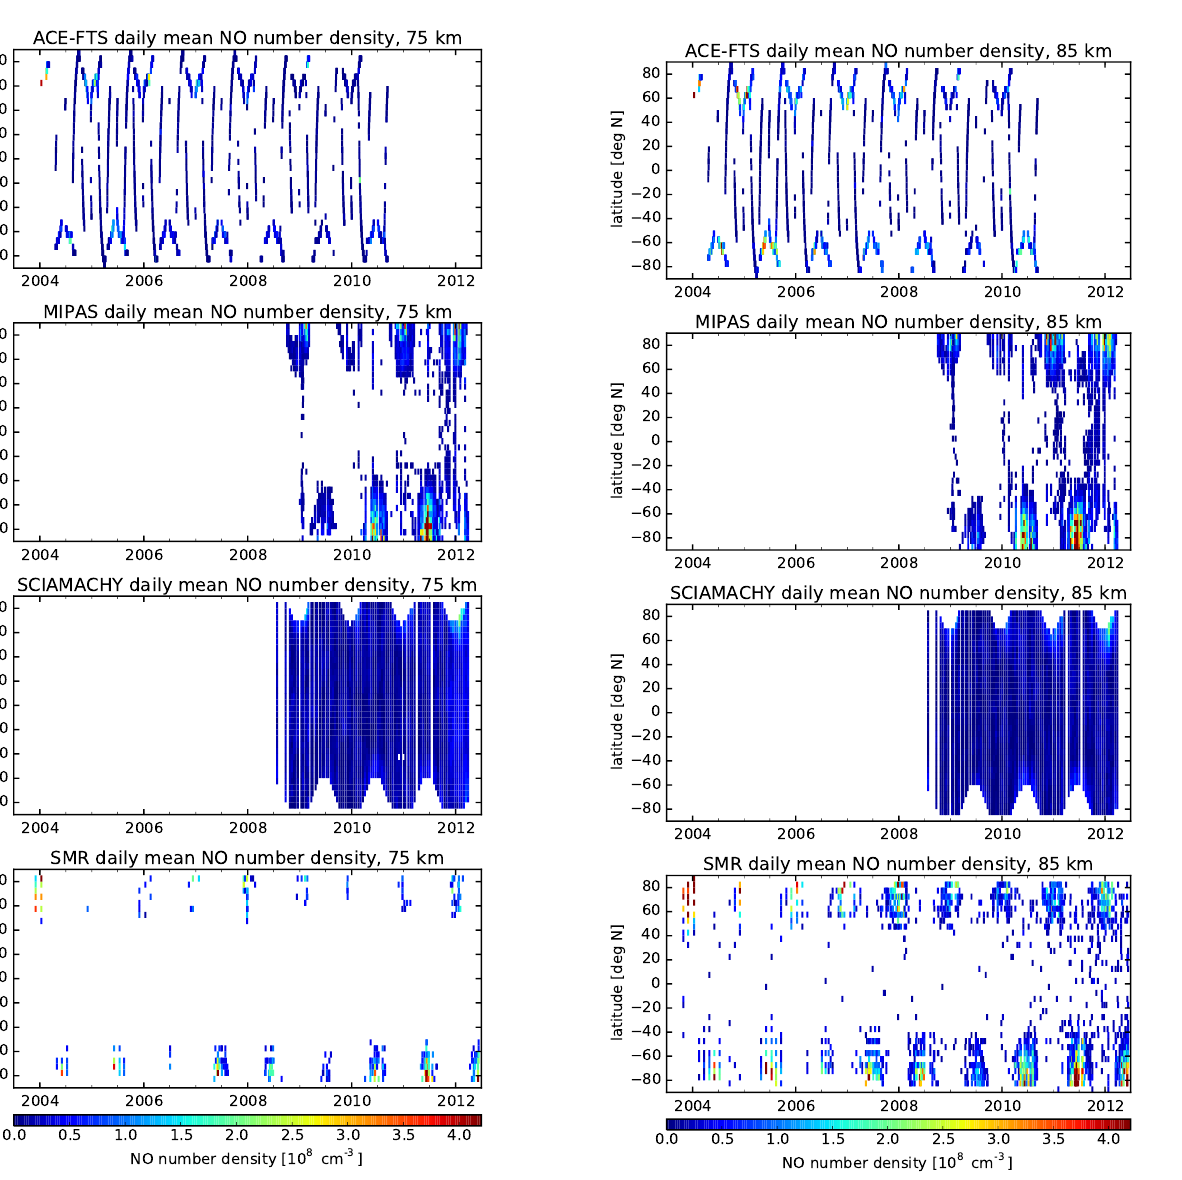
Figure A2. NO zonal mean time series at 85km from ACE-FTS, MIPAS, SCIAMACHY, and SMR (from top to